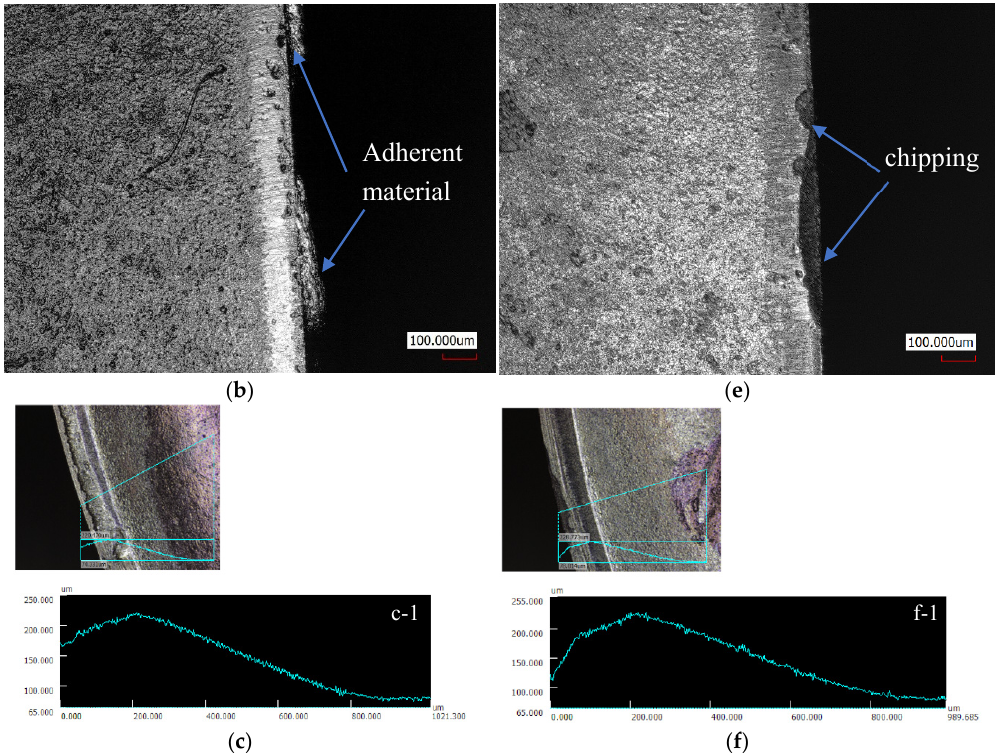
Figure 9. Wear of cutting edge: ( a – c ) WC–Co insert with W–B coating; ( d – f ) WC–Co. ( c-1 ): enlarged insert (chart) from Figure 9c; ( f-1 ): enlarged insert (chart) from Figure 9f. Table 6. Results of flank wear V B after turning test for WC–Co insert and W–B coated insert.